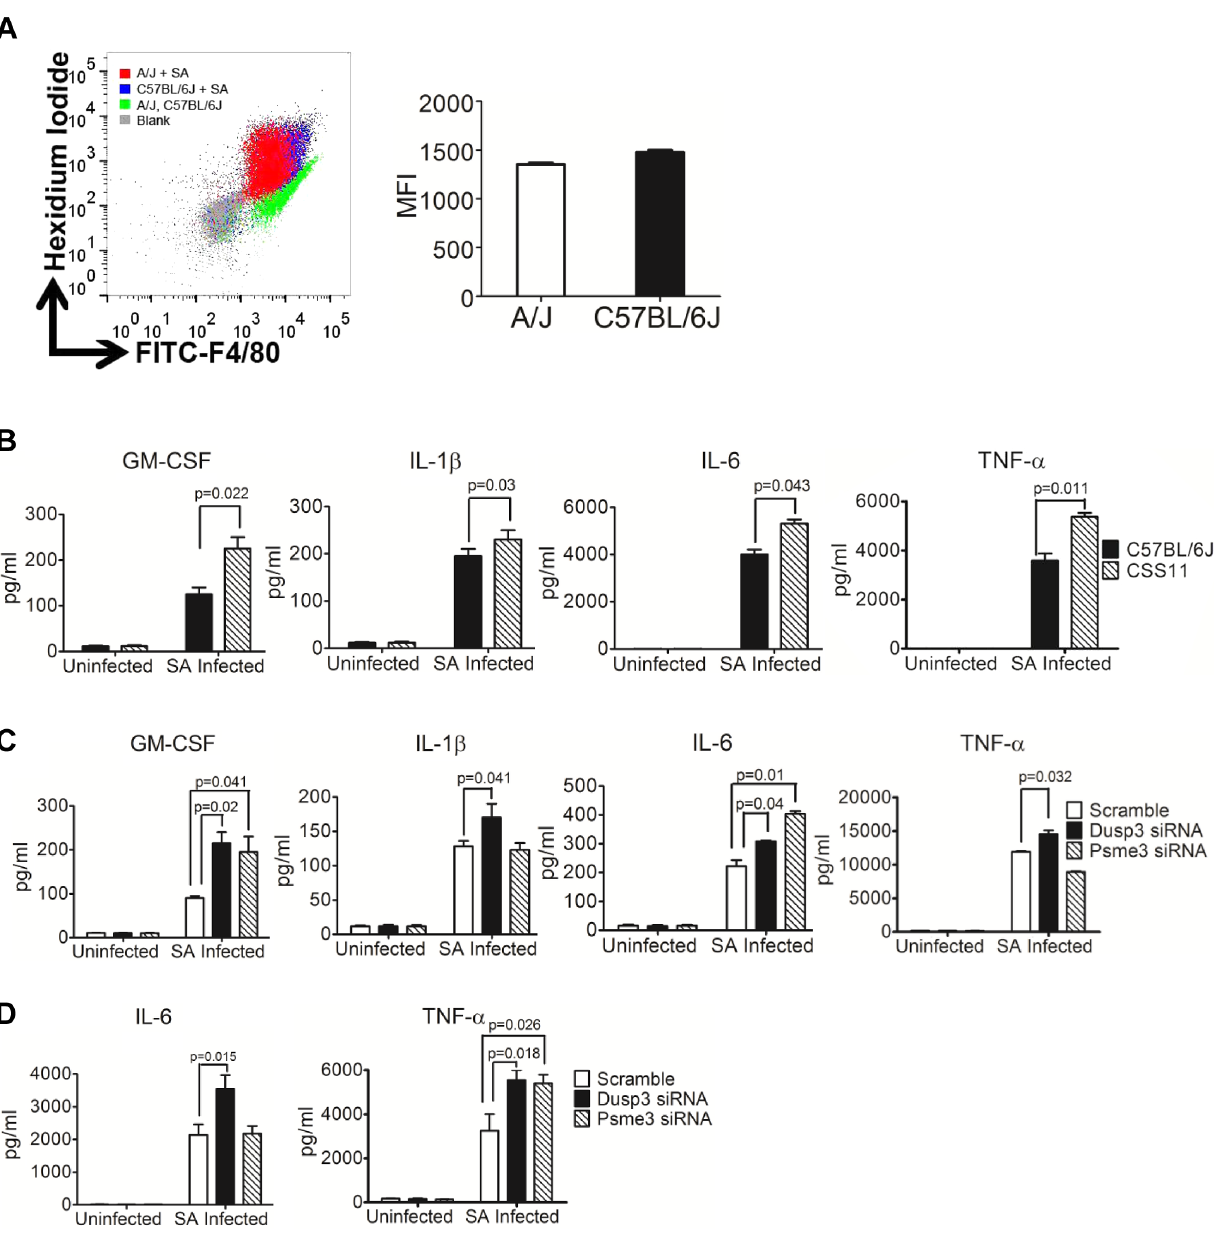
Figure 5. siRNA knockdown of Dusp3 and Psme3 result in significant elevation of cytokine production, consistent with the pattern of bone marrow derived macrophages from CSS11 as compared with C57BL/6J (GM-CSF, IL-1 b , IL-6 and TNF- a ). ( A ) Bone-marrow derived macrophages (BMDMs) from A/J and C57BL/6J have similar S. aureus phagocytosis ability. 2 6 10 6 BMDMs were seeded to single wells in a 6-well plate the day before phagocytosis and incubated with hexidium iodide stained S. aureus . Phagocytic efficiency as determined by the mean fluorescence intensity (MFI) is not significantly different in BMDMs from C57BL/6J and CSS11 mice. Representative histogram of 3 separate experiments. ( B ) BMDMs from CSS11 mice produced significantly higher cytokine levels as compared to C57BL/6J. 4 6 10 5 BMDMs from both C57BL/6J and CSS11 mice were seeded to single-wells of a 24-well plate the day before infection. Infection was simulated by adding S. aureus particles at 10 m g/ml. At 24 hours post-infection the supernatants were harvested and subjected to Luminex cytokine assaying. BMDMs from CSS11 mice significantly enhanced cytokine production, including GM-CSF, IL-1 b , IL-6, and TNF- a . ( C ) Down-regulation of Dusp3 and Psme3 by siRNA led to up-regulation of cytokine production upon S. aureus challenge in RAW264.7 macrophages. RAW264.7 cells were transfected by either scramble or Dusp3 or Psme3 siRNA, and then infected with S. aureus particles at 10 m g/ml as before [11]. At 24 hours post-infection, the supernatants were harvested and subjected to Luminex-multiplex cytokine assaying. The down-regulation of Dusp3 significantly enhanced cytokine production, including GM-CSF, IL-1 b , IL-6, and TNF- a , as compared to scramble siRNA control. The down-regulation of Psme3 also significantly elevated GM-CSF and IL-6 production. ( D ) Down- regulation of Dusp3 or Psme3 by siRNA led to up-regulation of cytokine production upon S. aureus challenge in BMDMs. BMDMs from C57BL/6J were transfected by either scrambled, Dusp3 or Psme3 siRNA, and then infected with S. aureus particles at 10 m g/ml. At 24 hours post-infection, the supernatants were harvested and subjected to cytokine analysis. The down-regulation of Dusp3 significantly enhanced cytokine production, including IL-6 and TNF- a , as compared to scrambled siRNA control. The down-regulation of Psme3 also significantly elevated TNF- a production.